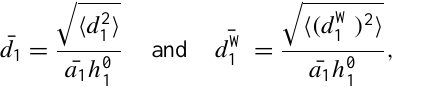
with f = f 0 + βy . When waves propagate northward the magnitude of their latitudinal wave number has to